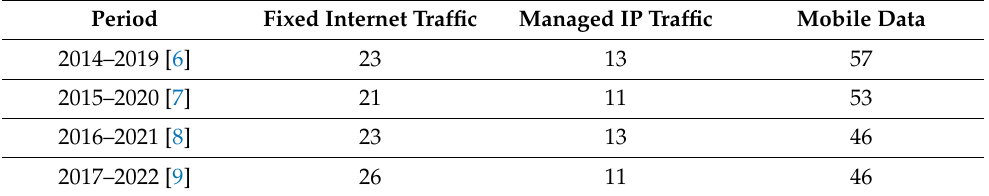
Table 1. Compound Annual Growth Rate (CAGR) reported in Cisco’s VNI over four consecutive years.